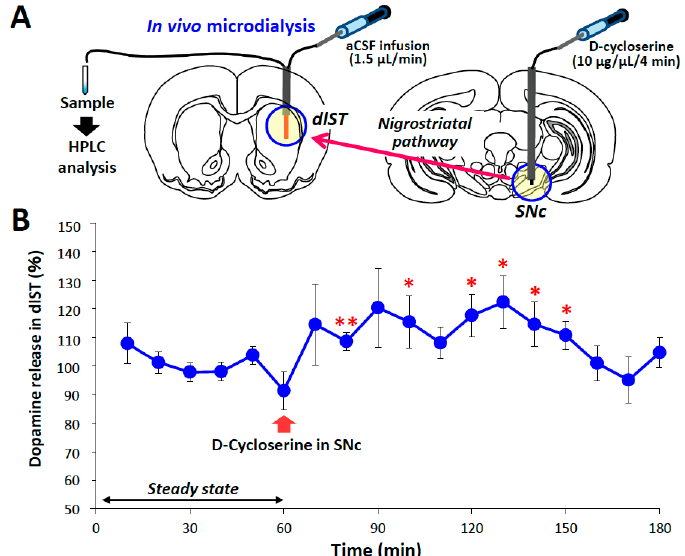
Figure 5. Effects of an intranigral microinjection of D -cycloserine (DCS) on dopamine release in the rat striatum. ( A ) Schematic drawing illustrating the microinjection site of DCS in the substantia nigra pars compacta (SNc) and microdialysis site in the dorsolateral striatum (dlST); ( B ) Extracellular levels of dopamine were analyzed in 10-min dialysate samples. Data were normalized to the mean value of the first six 10-min samples (basal value). Each column shows the mean ± S.E.M. of 6 rats. These data were analyzed by the Student’s t -test. * p < 0.05, ** p < 0.01, significantly different from the basal value.